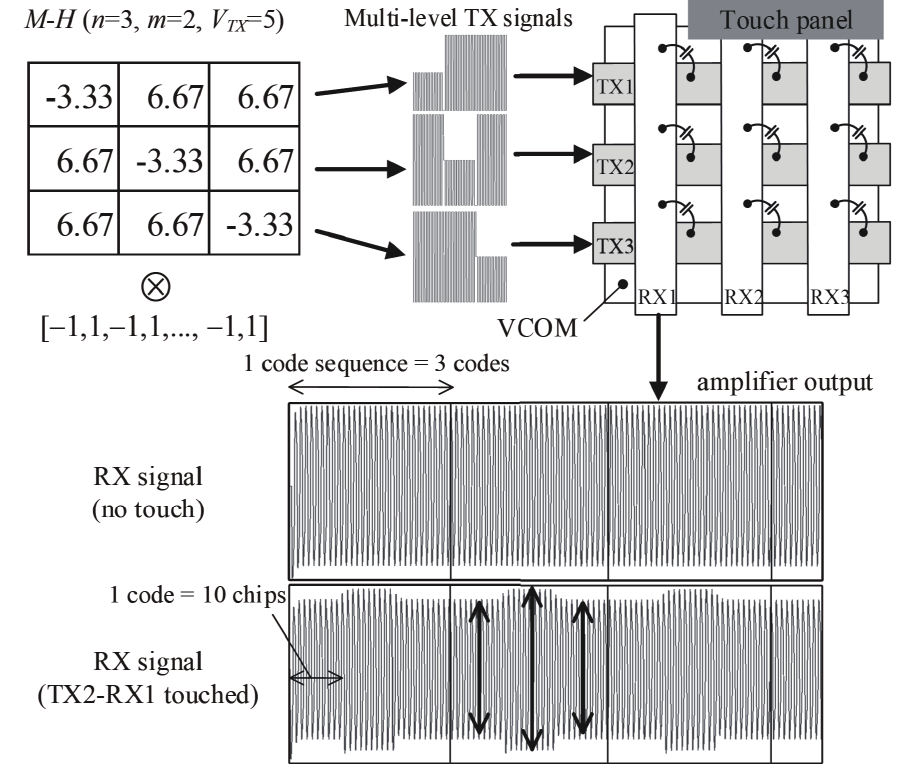
Figure 4. Multi-level TX sequence and the aggregated RX signal at the